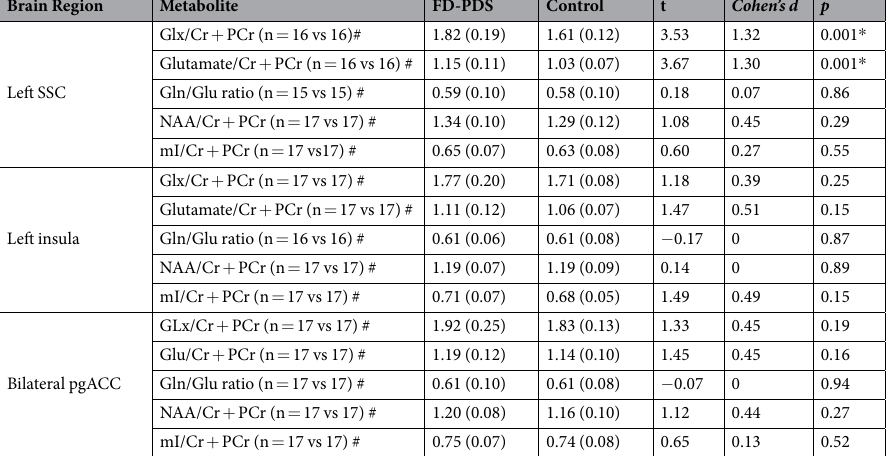
Table 1. Between-group Comparison of Metabolite concentrations. * Bonferroni corrected p < 0.003 ( = 0.05/(3 regions × 5 metabolite ratios)). # Number of subjects included in analysis after removing those with Cramer-Rao Lower Bound ratio > 20% for respective regional metabolite